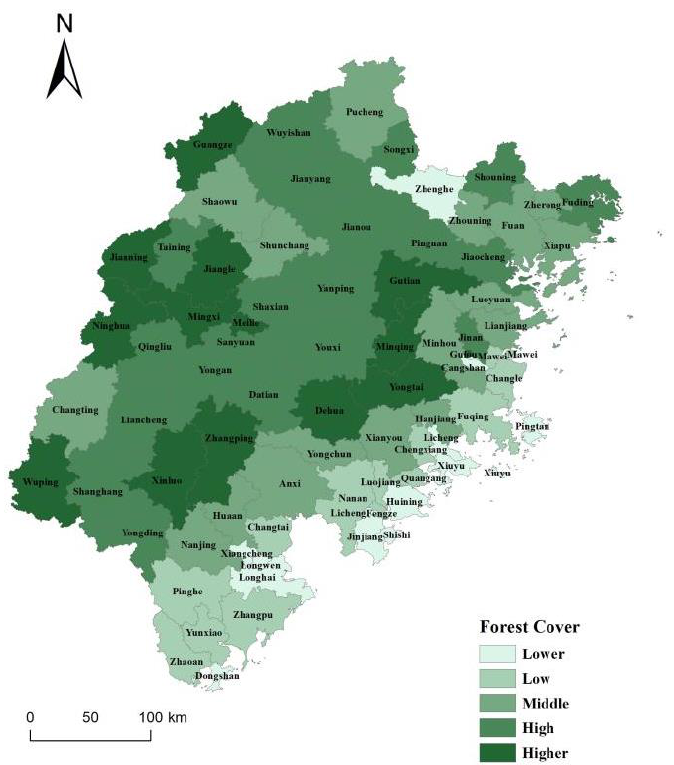
Figure 1. Spatial distribution of forest cover in Fujian Province in 2020.